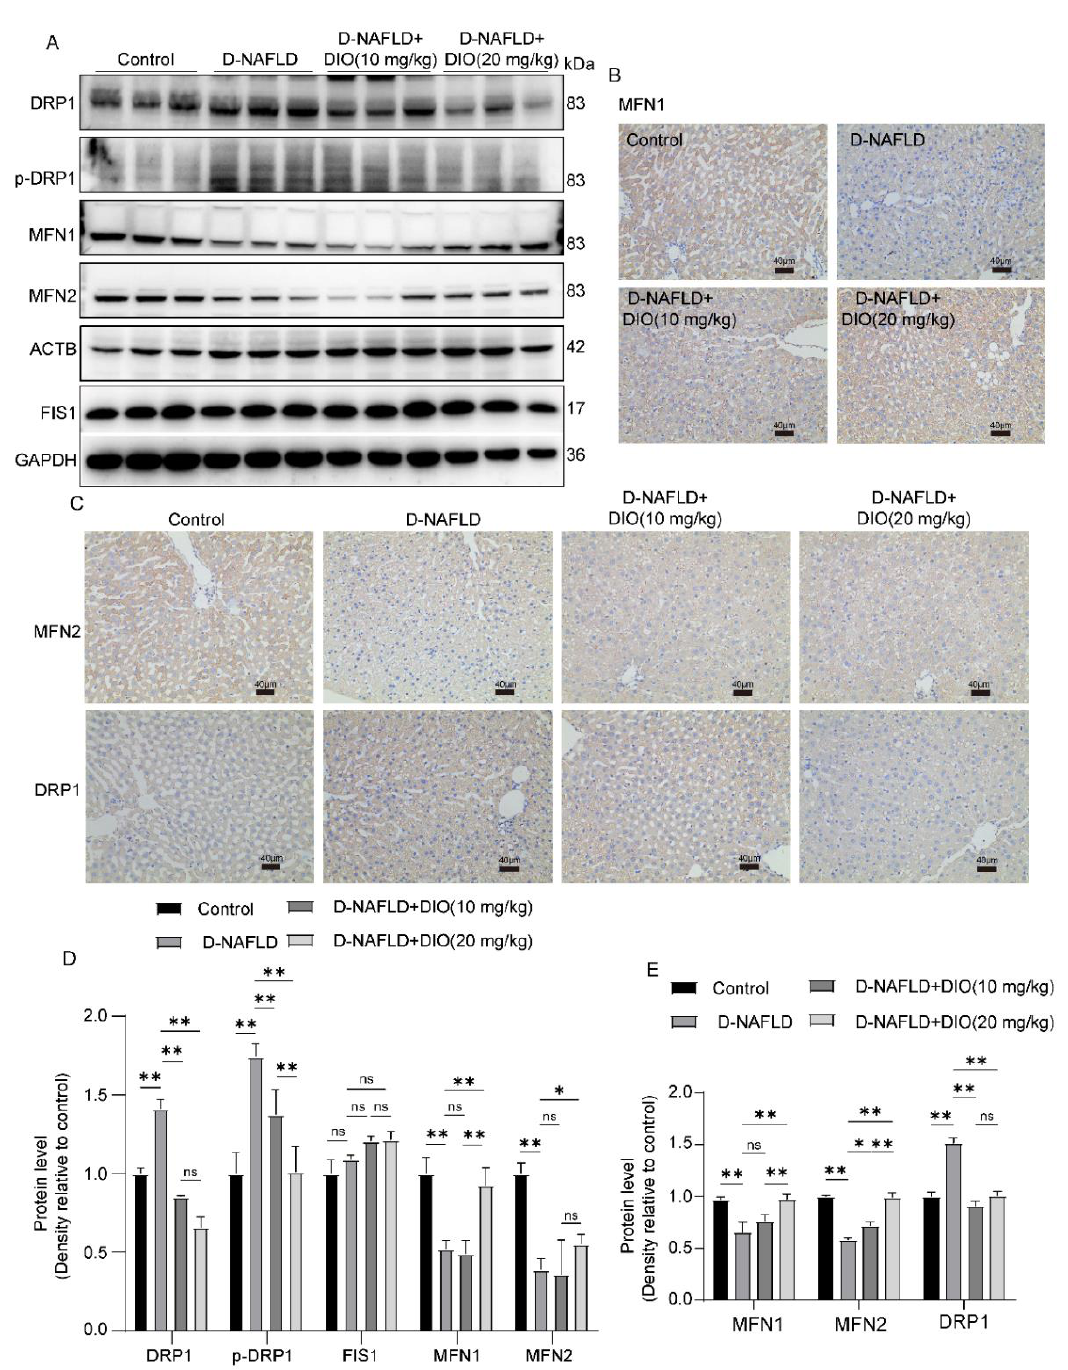
Figure 8. DIO ameliorated the disorder of mitochondrial fission and fusion in the liver of D-NAFLD rats. ( A ) Western blot images of DRP1, p-DRP1, MFN1, MFN2, FIS1, ACTB, and GAPDH. ( B ) The images of MFN1 immunohistochemistry, × 100, scale bars = 40 µ m. ( C ) The images of MFN2 and DRP1 immunohistochemistry, × 100, scale bars = 40 µ m. ( D ) Relative protein expressions of DRP1, p-DRP1, FIS1, MFN1, and MFN2. ( E ) Positive staining area of MFN1, MFN2, and DRP1 immunohistochemistry. n = 3 and the data were presented as mean ± SD. ns indicates no significance, * and ** indicate significant difference and highly significant difference,